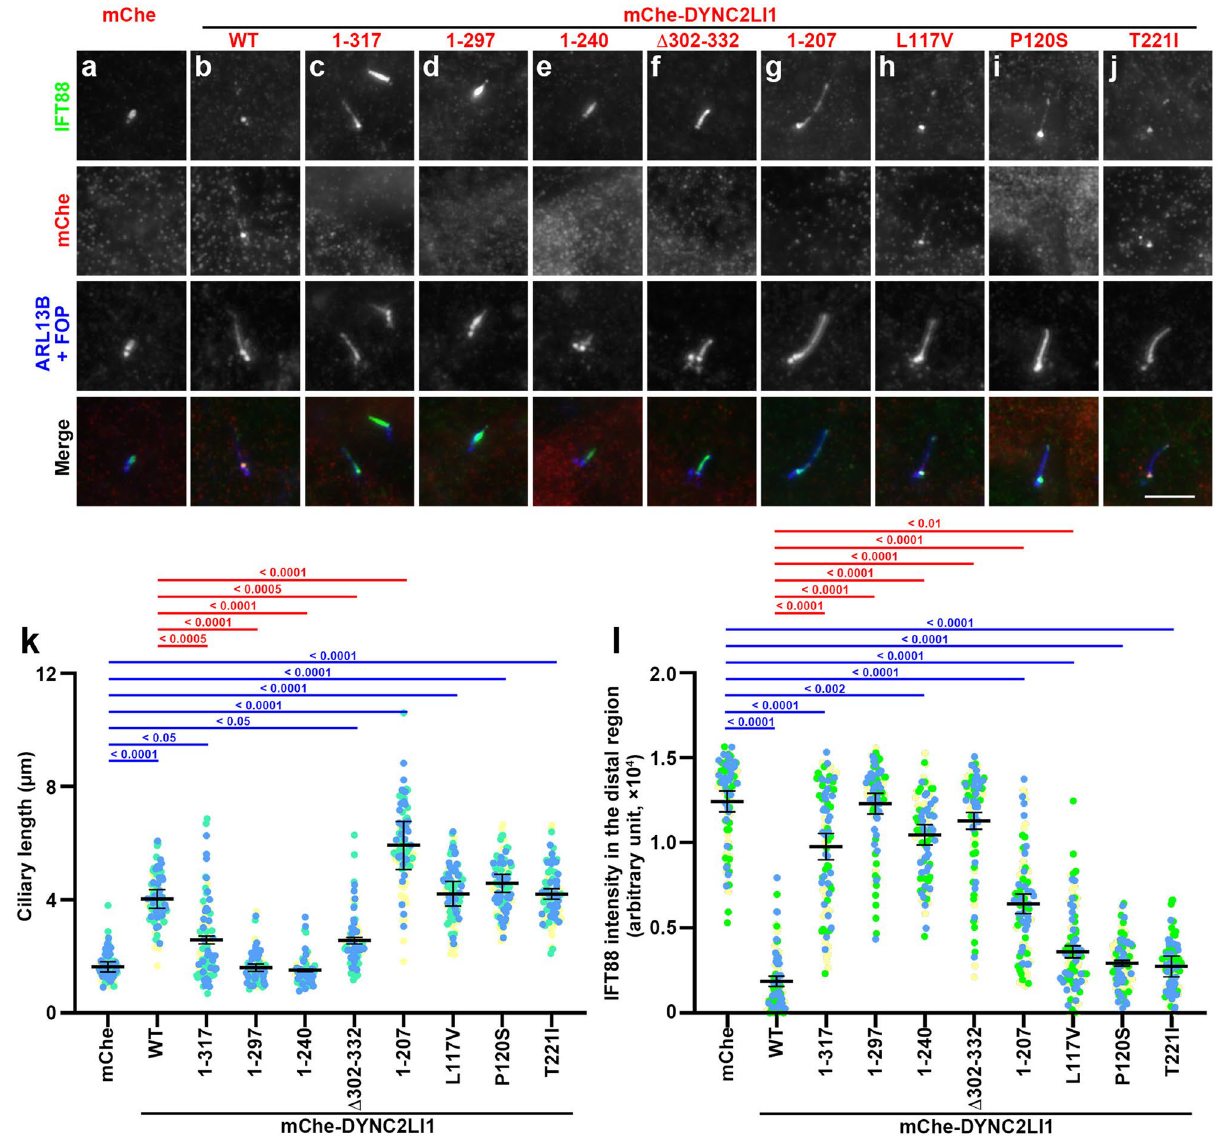
Figure 2. Effects of the expression of DYNC2LI1 variants on ciliogenesis and IFT88 localization in DYNC2LI1 -KO cells. ( a – j ) DYNC2LI1 -KO cells expressing mChe ( a ), or mChe-fused DYNC2LI1 constructs as indicated ( b – j ) were serum-starved for 24 h to induce ciliogenesis, and immunostained with antibodies against IFT88 and ARL13B + FOP. Scale bar, 5 µm. ( k ) Ciliary lengths of individual cells were measured and expressed as scatter plots. ( l ) Relative staining intensities of IFT88 in the distal region of cilia were estimated and expressed as scatter plots. Different colored dots represent three independent experiments ( n = 30 × 3). Horizontal lines are means, and error bars are SD. Statistical significances were calculated using one-way ANOVA followed by the Dunnett’s multiple comparison